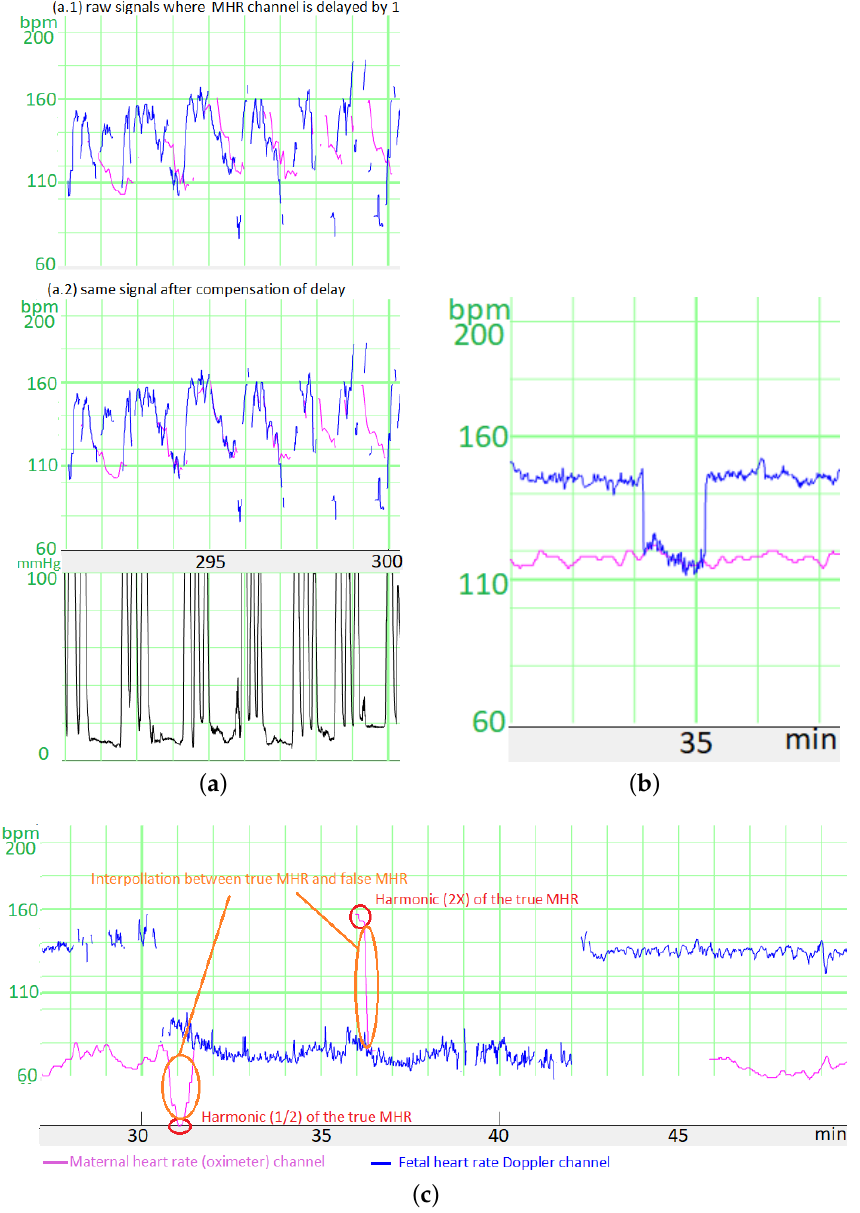
Figure A1. Illustration of the effects produced by CTG monitors, complicating the recognition of FSs. These effects are due to the autocorrelation algorithm used to estimate heart rate. ( a ) Example of an FHR FS in a second stage recording, with and without correction for the lag in the MHR channel. ( b ) Example of a continuous transition over ≈ 1 s in the FHR signal. ( c ) Example of a continuous transition over ≈ 20 s in the MHR signal measured with finger oximeter, when switching to an FS. This was due to the broad autocorrelation window used by the CTG monitor to compute the MHR from the oximeter